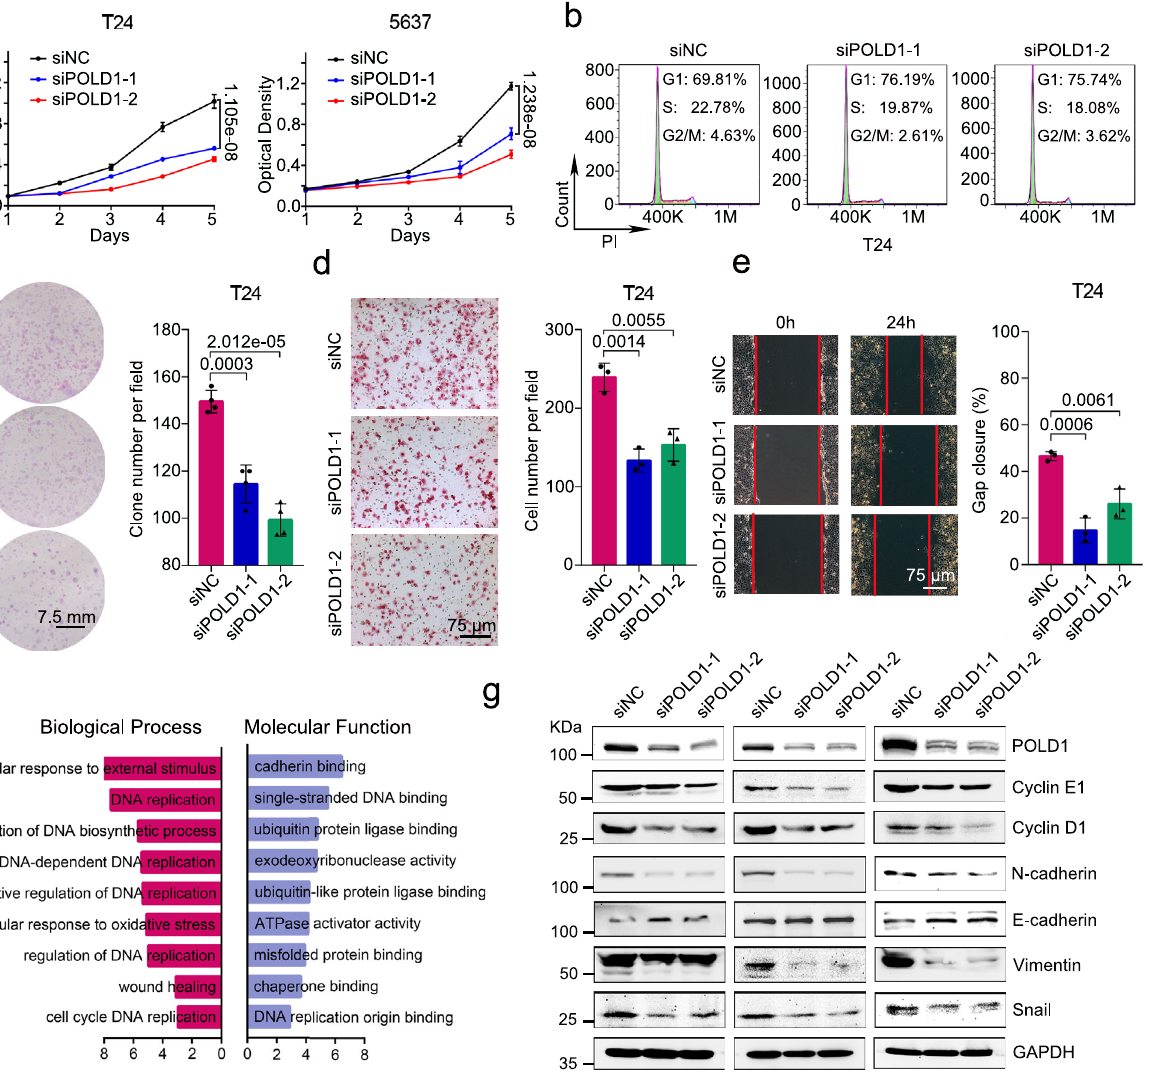
e Representative images (left panel) and statistical results (right panel) of the woundhealingassayinT24cellswithorwithout POLD1 depletion( n =3biologically independent experiments in each group). Gap closure (%) = (0h distance − 24h distance)/0h distance 100%. The “ distance ” here refers to the shortest distance between the red lines in the diagram. f Gene Ontology (GO) biological processes (red)and molecular functions (blue) related toPOLD1 from enrichment analysisof differentially expressed genes (DEGs) from RNA-seq assays. The GO analysis here was performed by the R package “ clusterPro fi ler ” . p values computed using two- tailedFisher ’ sexacttestwith p value<0.05wereusedasthethresholdforstatistical tests. g Western blot analyses of cell cycle- and EMT-related proteins with or without POLD1 knockdowninT24,5637,andUM-UC-3cells.GAPDHwasusedasthe loading control. Statistical signi fi cance was determined by two-tailed Student ’ s T - test ( a , b , d , e ). Source data are provided as a Source Data fi